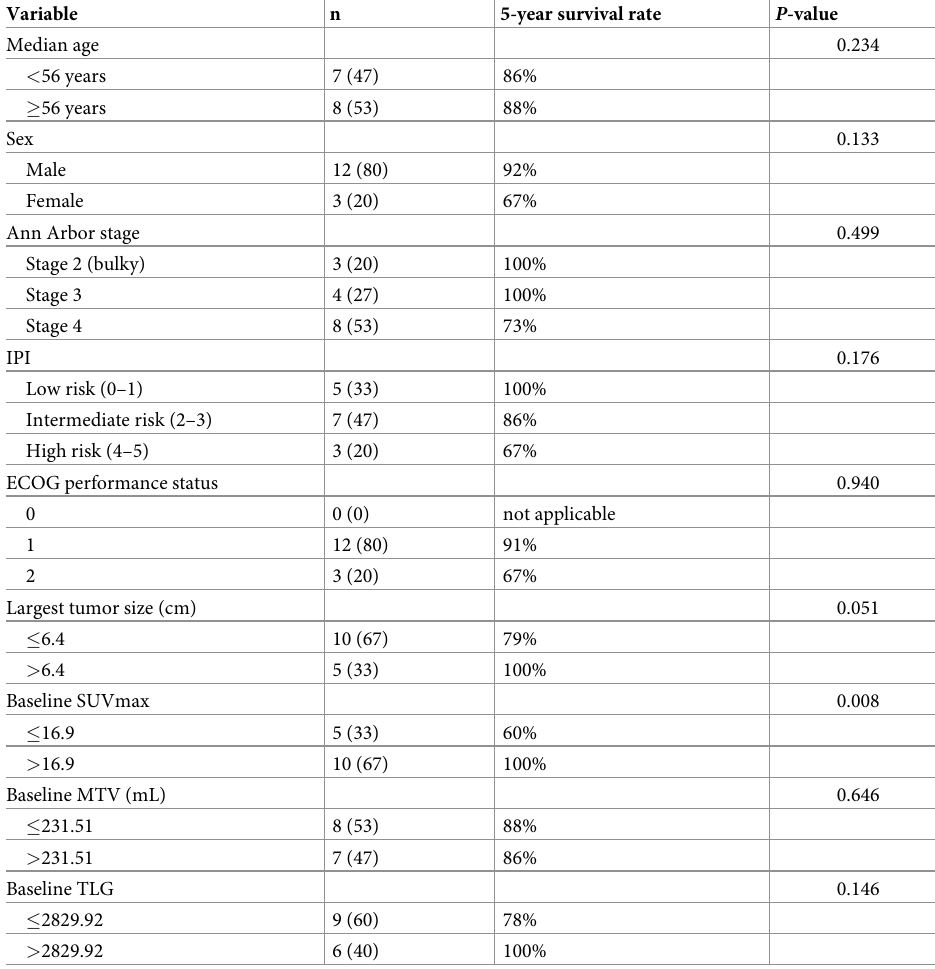
Table 2. Results of univariate Kaplan-Meier survival analysis for relapse free survival.